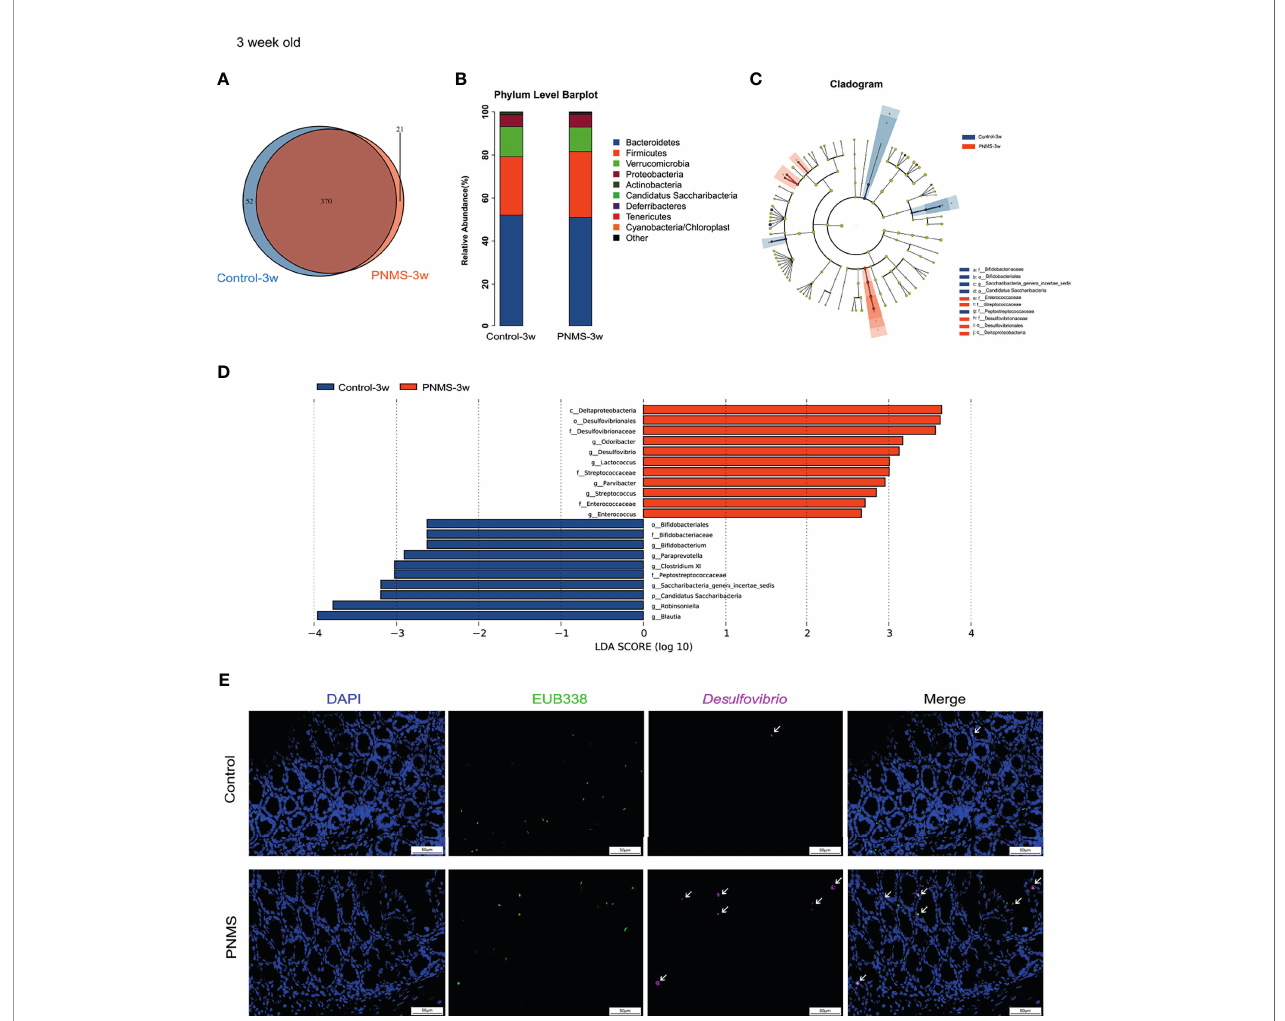
FIGURE 4 | Prenatal maternal stress induced dysbiosis of the gut microbiota in 3-week-old offspring. (A) Venn diagram of the operational taxonomic units (OTUs). (B) Microbial composition at the level of bacterial phylum. (C, D) Cladogram and the linear discriminant analysis (LDA) scores showed signi fi cant bacterial differences between the two groups by linear discriminant analysis effect size (LEfSe). (E) Fluorescence in situ hybridization (FISH) detection of Desulfovibrio in colon tissues of the control and PNMS offspring using a fl uorescein isothiocyanate (FITC)-conjugated universal bacterial 16S rDNA-directed oligonucleotide probe (EUB338, green ) and Cy5- conjugated Desulfovibrio speci fi c probe ( red ). PNMS , prenatal maternal stress. Scale bar , 50 m m. Magni fi cation, ×400. Control-3w ( n = 15) vs . PNMS-3w ( n =